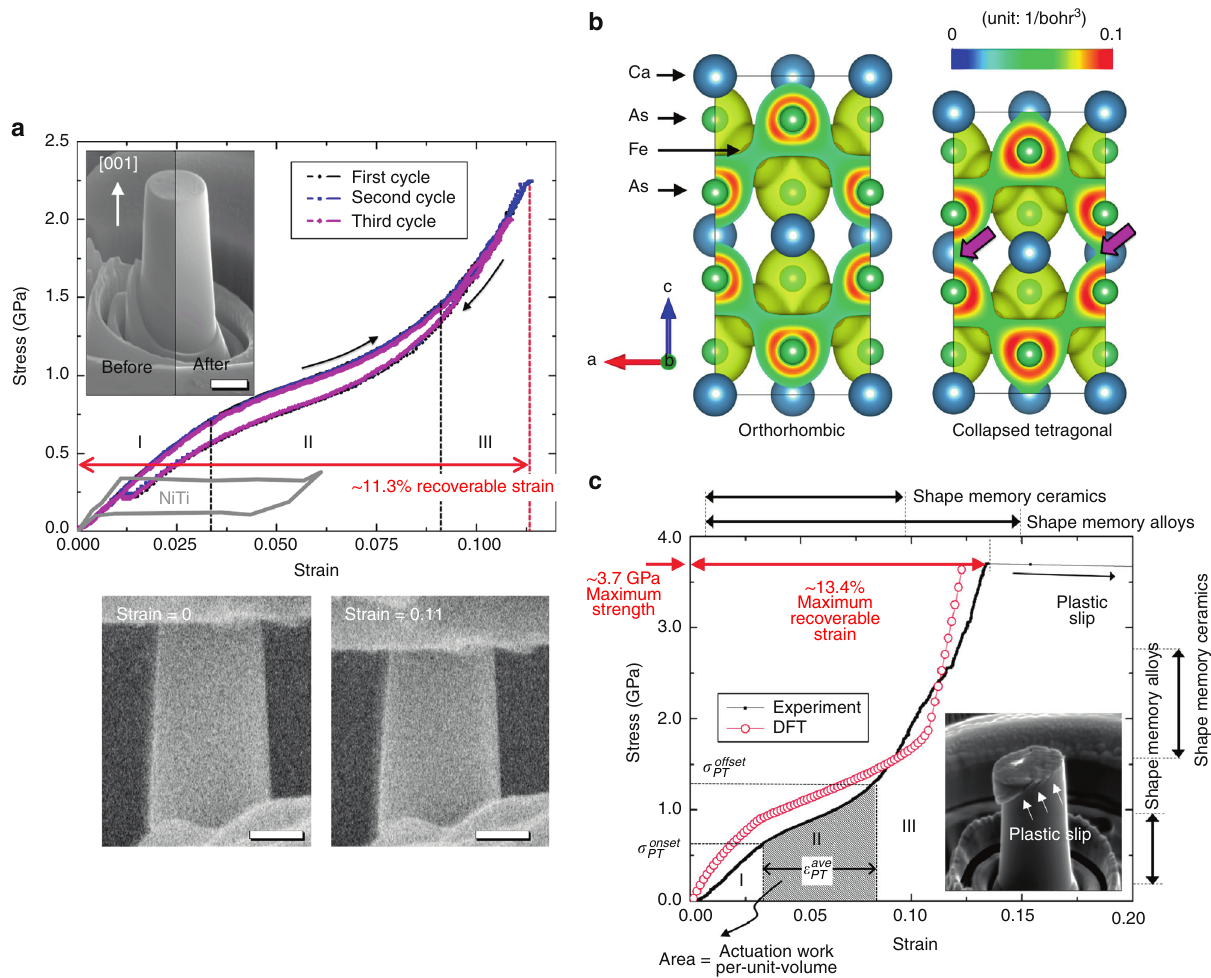
Fig. 2 Demonstration of superelasticity including large recoverable strains and high yield strengths. a A three stress – strain curves of same [001]-oriented CaFe 2 As 2 micropillar; the inset shows no height change even after three cycles of 11.3 % strain compression. Remarkably, the stress – strain curves appear identical, indicating that there is no residual damage accumulation during cyclic deformation, which is typically observed in shape memory alloys or ceramics especially at small length scales 7, 11 . Stress – strain data of Ni-Ti alloy also was included for comparison. Two snapshots of in situ compression show the signi fi cant compressive elastic deformation, which cannot be achieved in other metallic or intermetallic materials; scale bar, 1 μ m. b Electron density distributions at ambient pressure and under c-axis compression; the formation of As – As bonding, which is indicated by arrows, induces the structural collapse and the 10% height reduction. The iso-surface level used was 0.035 and the max is 0.1 (red). c Experimental and computational (DFT) stress – strain curves of [001]-oriented CaFe 2 As 2 micropillar up to the yield point. We intentionally terminated the stress – strain data of DFT simulation at the experimental yield strength because the remaining data above the yield strength is not meaningful in the current analysis. The inset shows the plastic slip in the ½ 301 (cid:2)ð 103 Þ slip